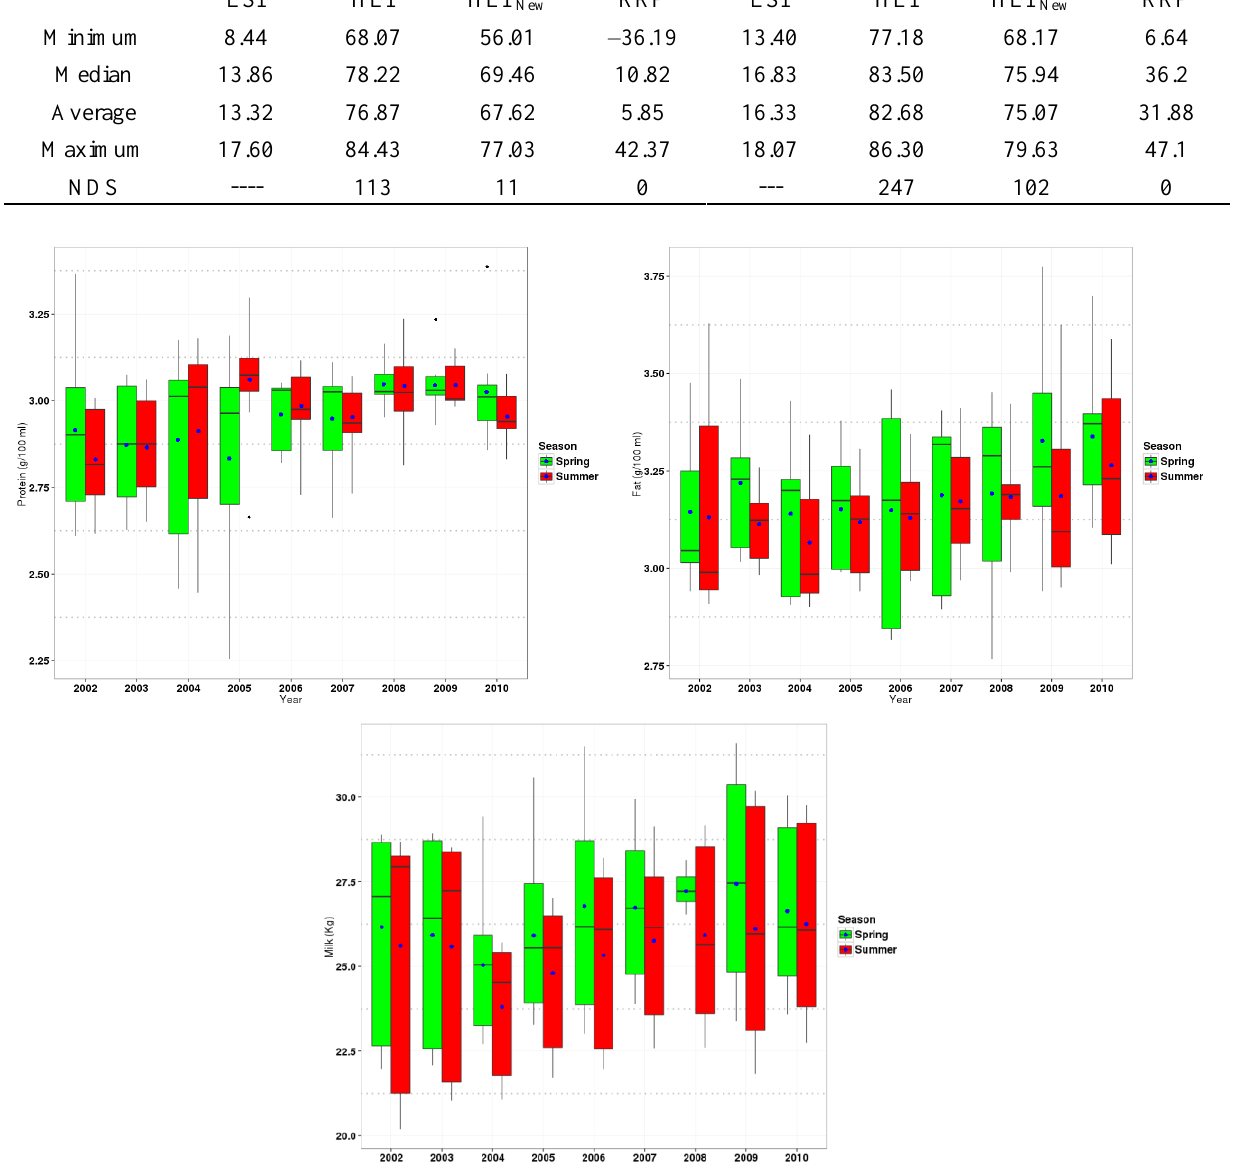
Figure 3. Lines inside the plot boxes indicate the median and the points show the season averages of the milk compounds milk yield (Kg), fat (g/100 mL milk), and protein (g/100 mL milk) in fresh products in the spring and summer from 2002 to